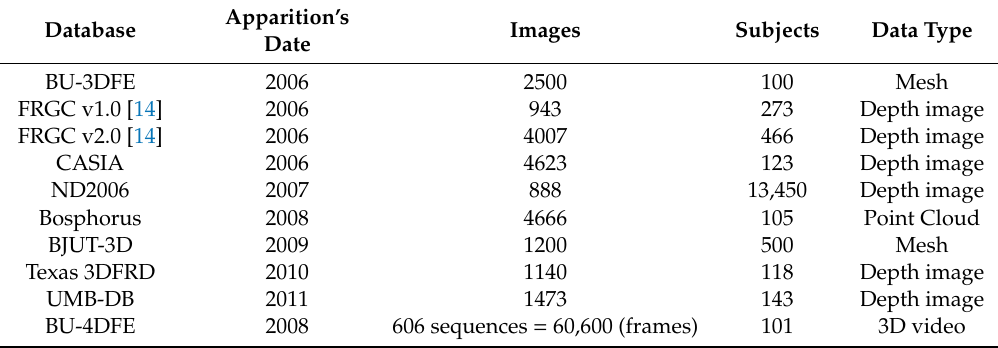
Table 4. Comparative summary of some accessible 3D face recognition databases.